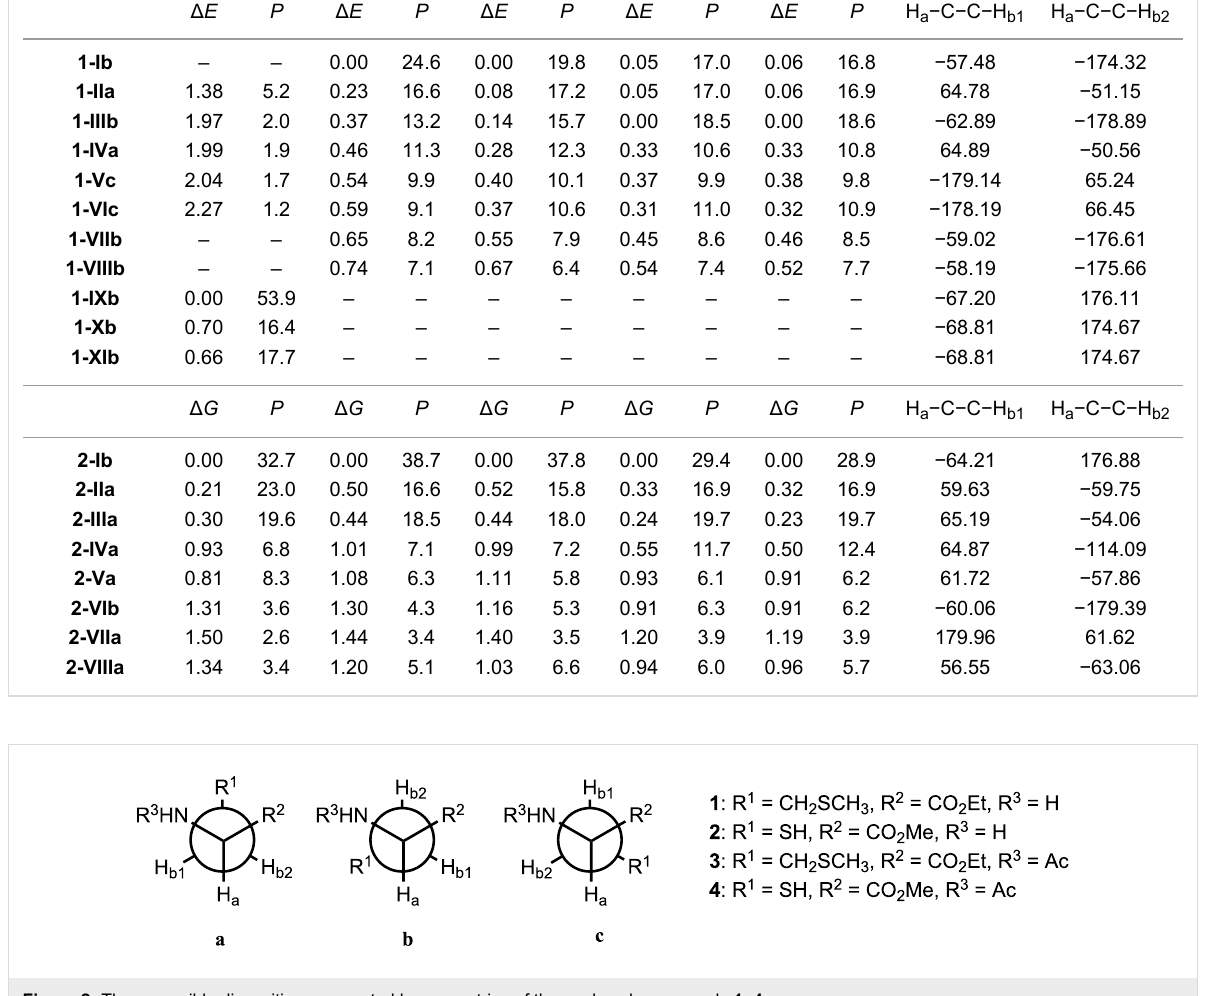
Table 2: Calculated parameters ( ω B97X-D/aug-cc-pVTZ) for the conformers of 1 and 2 . Relative Gibbs free energy ( Δ G ) and electronic energy with ZPE corrections ( Δ E ) are given in kcal mol − 1 , populations ( P ) in % and dihedral angles in degrees. conformer